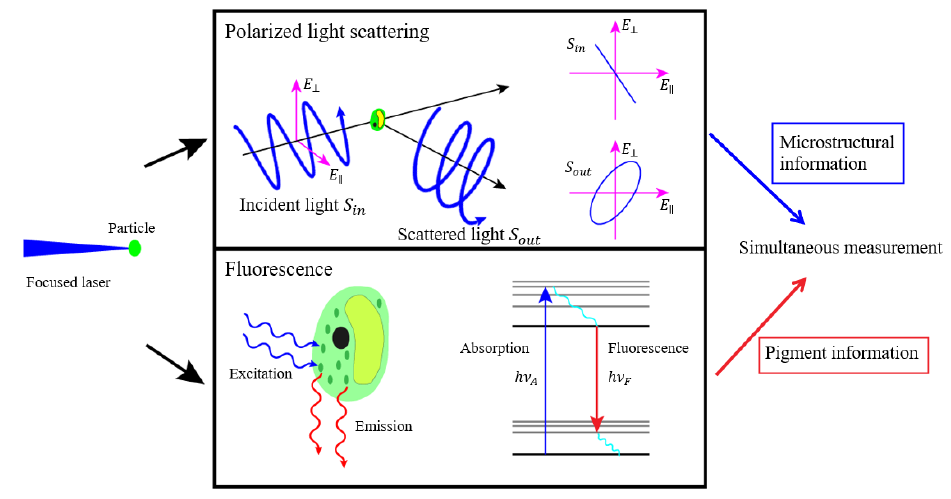
Figure 1. The schematic diagram of the physical mechanism.